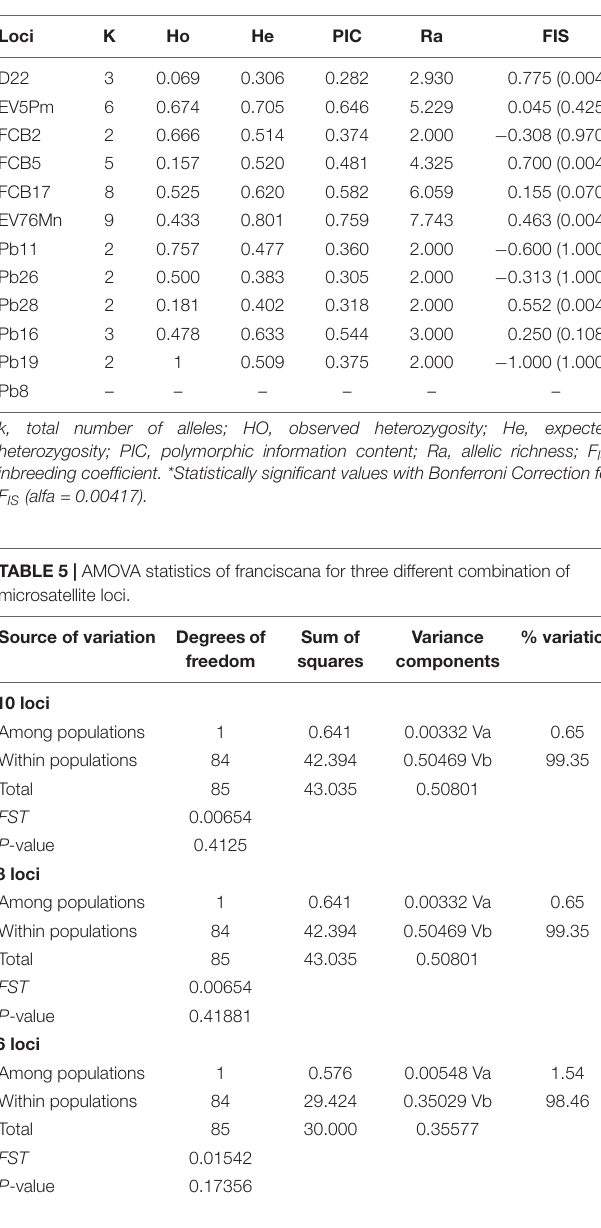
TABLE 4 | Genetic diversity of franscicana for twelve microsatellite loci.